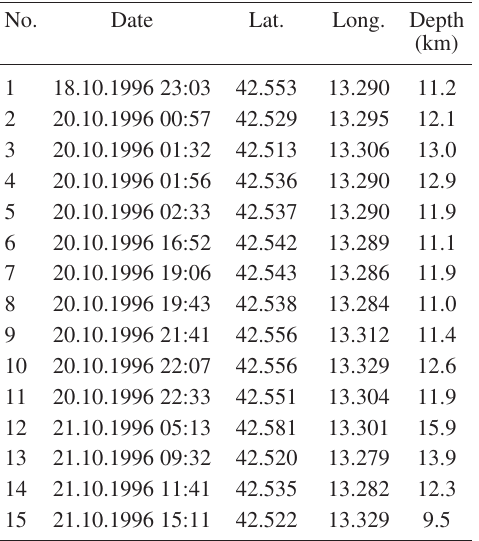
Table II. Hypocentral parameters from relative lo- cation of the October 1996 seismic sequence (main shock = master